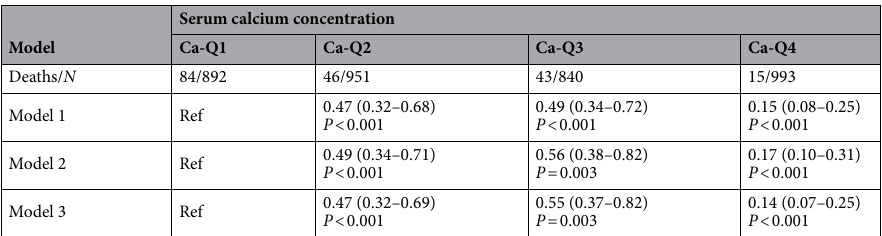
Table 2. The association between serum calcium concentration and in-hospital mortality of patients with acute myocardial infarction analyzed using three different logistic regression models. Data are presented